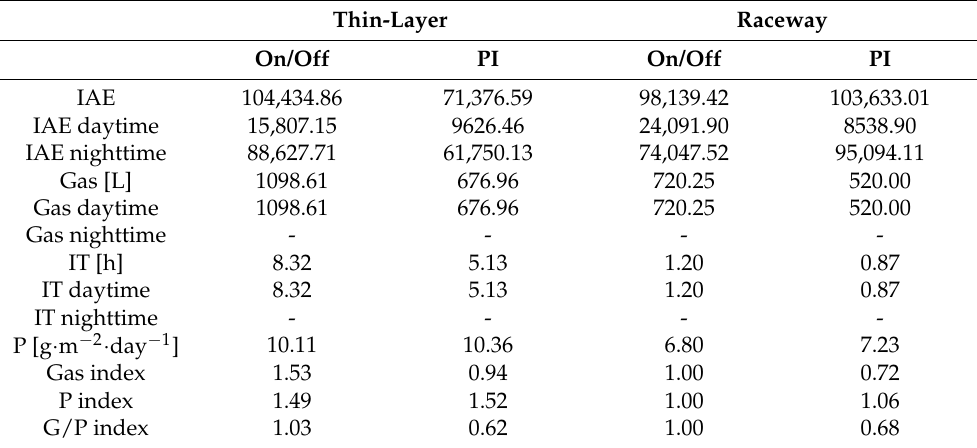
Table 3. Performance measurements of control On/Off and Proportional–Integral–Derivative (PID) operated during the daytime